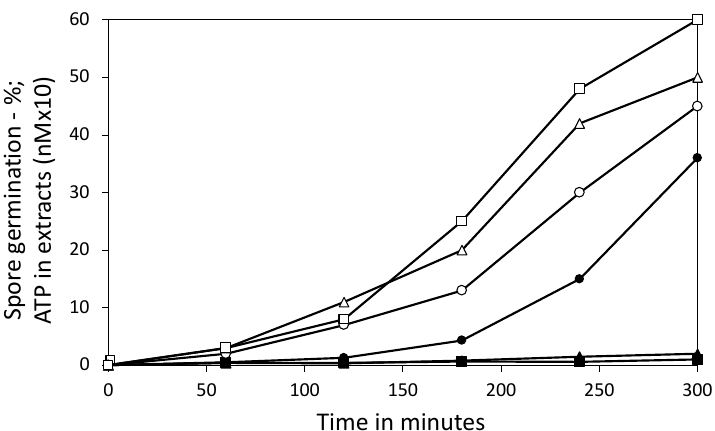
Figure 3. Germination and ATP generation of spores incubated with CaDPA. Strains used: PS832, wt and have 3PGA ( , • ); PS3406, CaDPA-less and no 3PGA ( (cid:52) , (cid:78) ); and FB113, can initiate but not complete germination, and have 3PGA ( (cid:3) , (cid:4) ). Spores were incubated at 23 ◦ C with 50 mM CaDPA (pH 7.5), plus 100 μ M L-alanine with the FB113 spores; spore germination ( , , ) and ATP levels ( , , ) were measured as described in the Methods section.